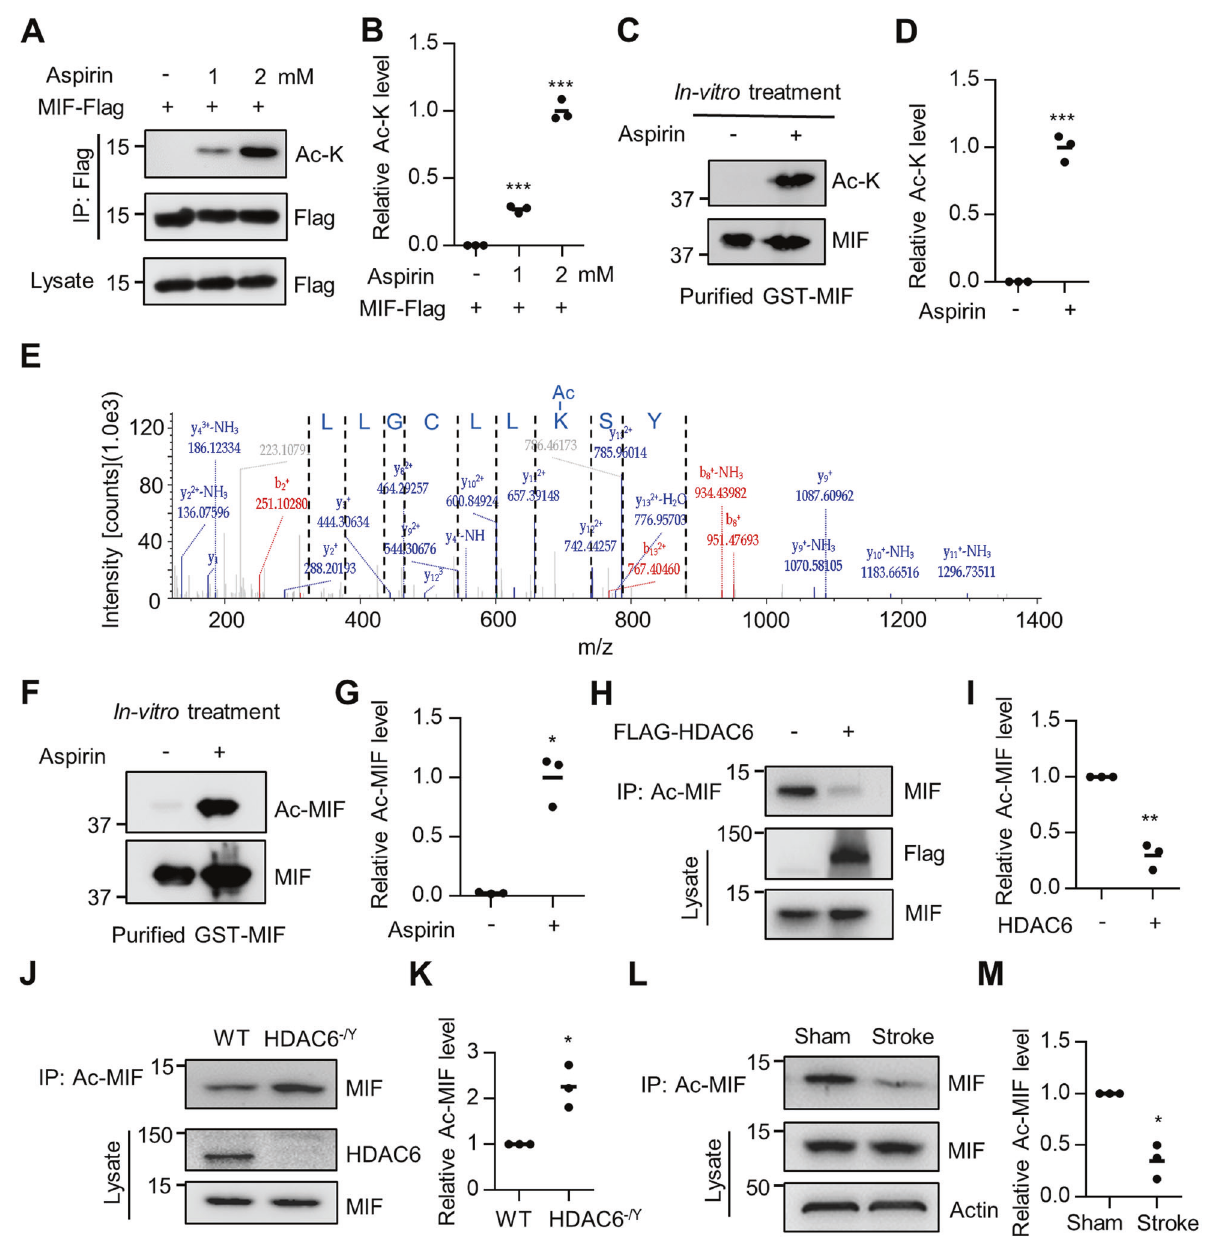
Fig. 2 Enhanced MIF acetylation with aspirin treatment. A Increased MIF acetylation in cells treated with aspirin. HEK293T cells were transfected with MIF-Flag and treated with aspirin at indicated concentrations. MIF protein was immunoprecipitated with anti-Myc antibody and probed with anti-Ac-K antibody. B Quanti fi cation of MIF acetylation showed in ( A ). Data shown were independent points and mean; one- way ANOVA; n = 3; *** p < 0.001. C Incubation of recombinant GST-MIF protein with aspirin (1 mM), and immunoblot with anti-Ac-K antibody. D Quanti fi cation of MIF acetylation showed in ( C ). Data shown were independent points and mean; paired t -test; n = 3; *** p < 0.001. E Representative K78-acetylated peptides of MIF were analyzed by mass spectrometry. HEK293T cells were transfected with MIF-Flag and treated with aspirin (2 mM). The MIF protein was immunoprecipitated with an anti-Flag antibody and acetylated peptides were analyzed by mass spectrometry. The y ion peaks are shown in blue, and the b ion peaks are shown in red. F Incubation of recombinant GST-MIF protein with aspirin at indicated concentrations, and immunoblot with MIF K78 acetylation antibody. G Quanti fi cation of MIF K78 acetylation is shown in ( F ). Data shown were independent points and mean; paired t -test; n = 3; * p < 0.05. H Decreased MIF K78 acetylation in HDAC6- overexpressing cells. HEK293T cells were transfected with Flag-HDAC6. Acetylated MIF protein was immunoprecipitated with anti-Ac-MIF antibody and probed with anti-MIF antibody. I Quanti fi cation of MIF K78 acetylation shown in H . Data shown were independent points and mean; paired t -test; n = 3; ** p < 0.01. J Increased MIF K78 acetylation in HDAC6 mutant cortex. Lysates from WT and HDAC6 mutant cortex were immunoprecipitated with anti-Ac-MIF antibody and probed with anti-MIF antibody. K Quanti fi cation of MIF K78 acetylation is shown in ( J ). Data shown were independent points and mean; paired t -test; n = 3; * p < 0.05. L Reduced MIF K78 acetylation in the penumbra regions of the cortex. Lysates of the cortex from the control and ischemia-induced mice were immunoprecipitated with anti-Ac-MIF antibody and probed with anti-MIF antibody. M Quanti fi cation of MIF K78 acetylation is shown in ( L ). Data shown were independent points and mean; paired t -test; n = 3; * p < 0.05.